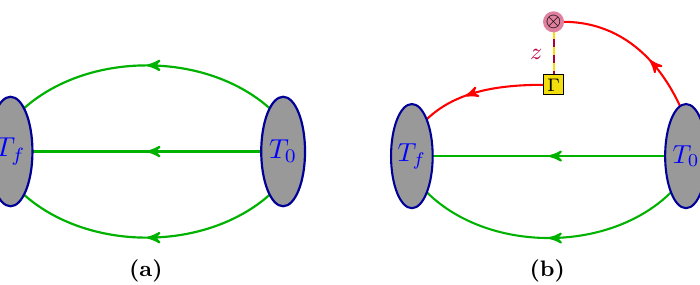
Figure 1. (a) Two-point and (b) Wilson-line type three-point correlation functions factorized into distinct elementals (blue), perambulators (green) and generalized perambulators